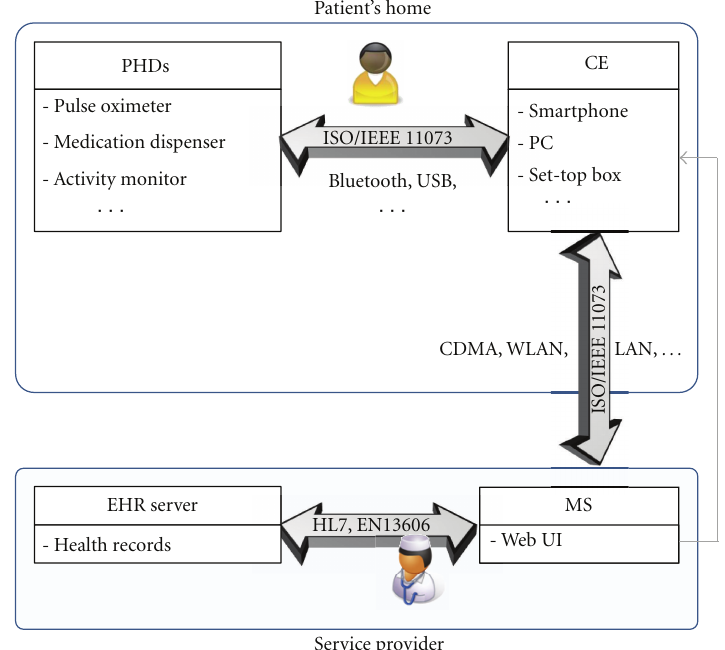
Figure 1: General architecture of u-healthcare system.